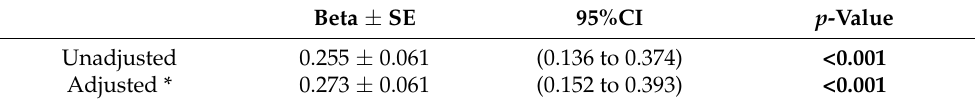
Table 3. Linear regression analyses for association between age at MS onset with